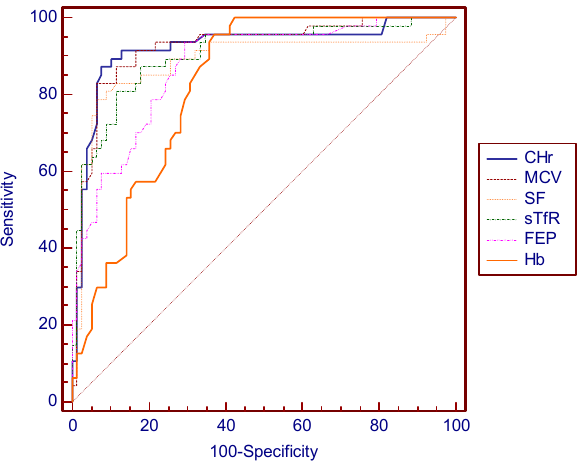
Figure 2. Comparison of ROC curves of CHr, MCV, SF, sTfR, FEP, and Hb diagnosing for IDA.